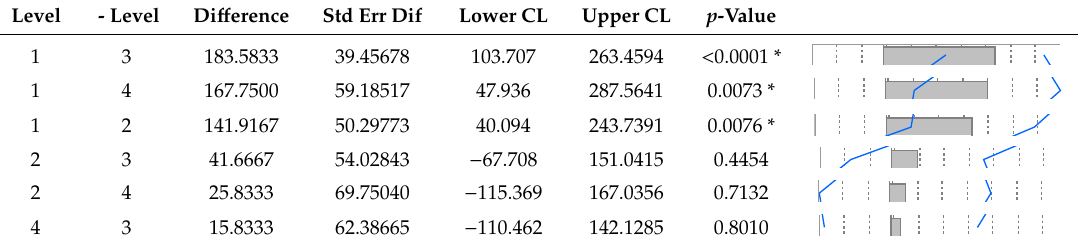
Table 5. Ordered difference report—recommended stand density.